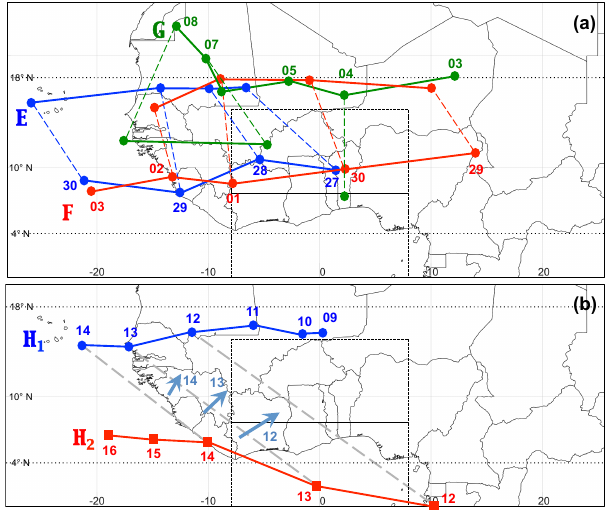
Figure 14. Significant synoptic-scale features during 27 June–16 July 2016 (beginning (a) and middle (b) of Phase 2). To create these graphs, vortices were subjectively identified in 850hPa streamlines based on operational ECMWF analyses. All vortex positions refer to 00:00UTC with the dates given as numbers. Round symbols mark cyclonic systems (labelled E, F, G and H 1 ), squares anticyclonic systems (labelled H 2 ). Vortices with a joint propagation are linked with dashed grey lines. The cores of significant 850hPa jets are indicated with light blue arrows, again with the date at 00:00UTC given as numbers. The boxes mark the areas used to compute the NSPD shown in Fig. 5a. The stippled lines show the latitude range used to produce Fig. 9.